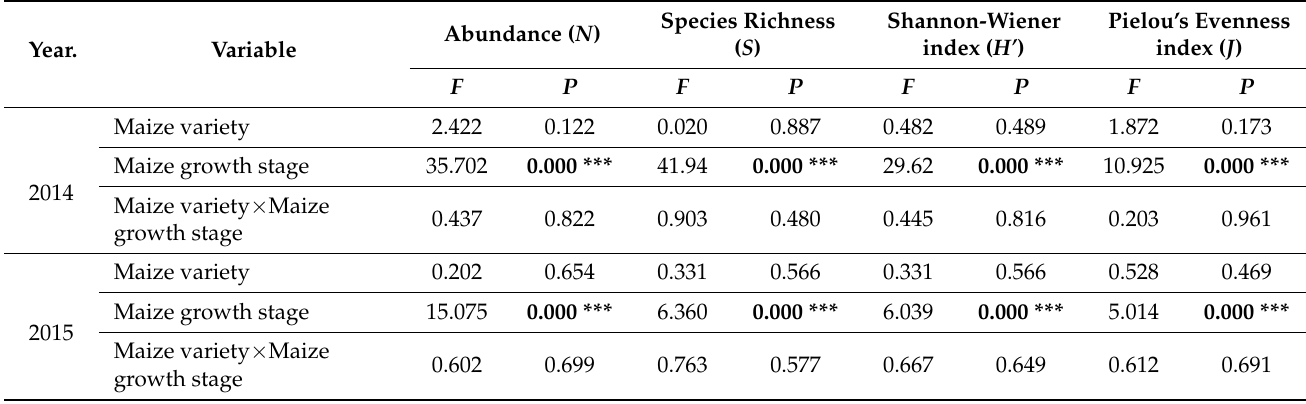
Table 3. Effects of maize variety (Bt maize and non-Bt maize) and maize growth stage on soil collembolan abundance and diversity, analyzed using a two-way ANOVA analysis. The values highlighted in bold are statistically significant (*** p <